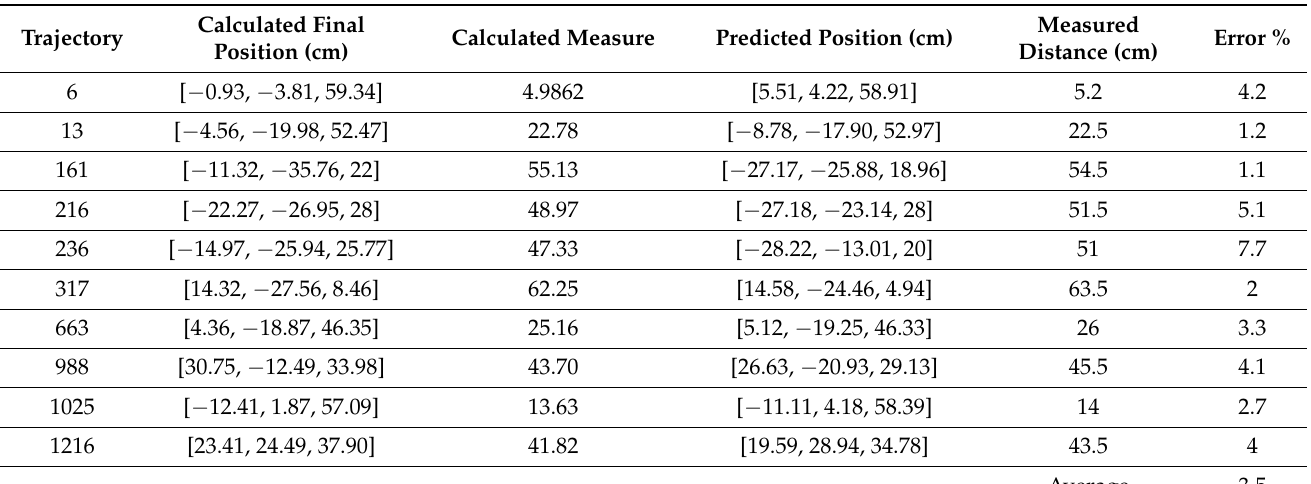
Table 10. Trajectory comparison.